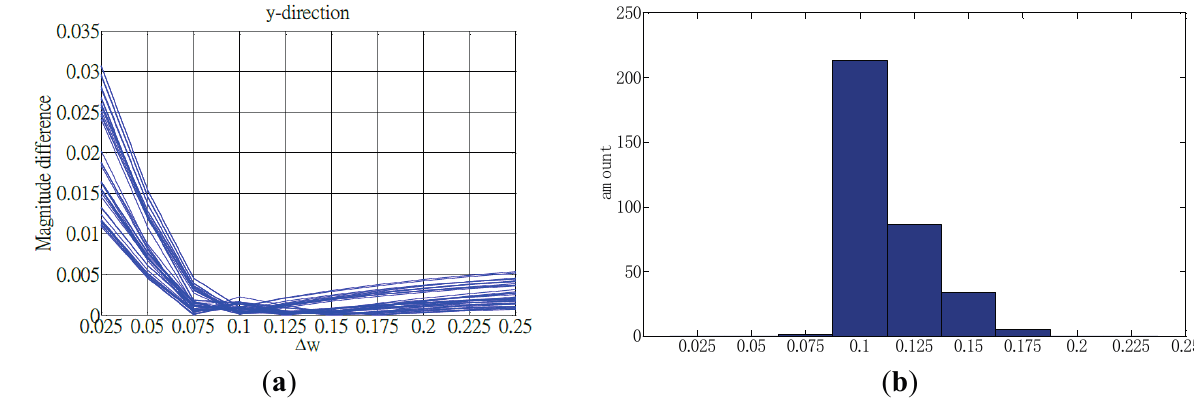
Figure 11. Magnitude difference and its counts with respect to the increment frequency for acceleration on the y -axis of Ex.4 (back shoulder circling exercise). ( a ) Magnitude difference versus the increment frequency used to identify the minimal Δ E; ( b ) Distribution of magnitude difference versus the increment frequency used to identify the most